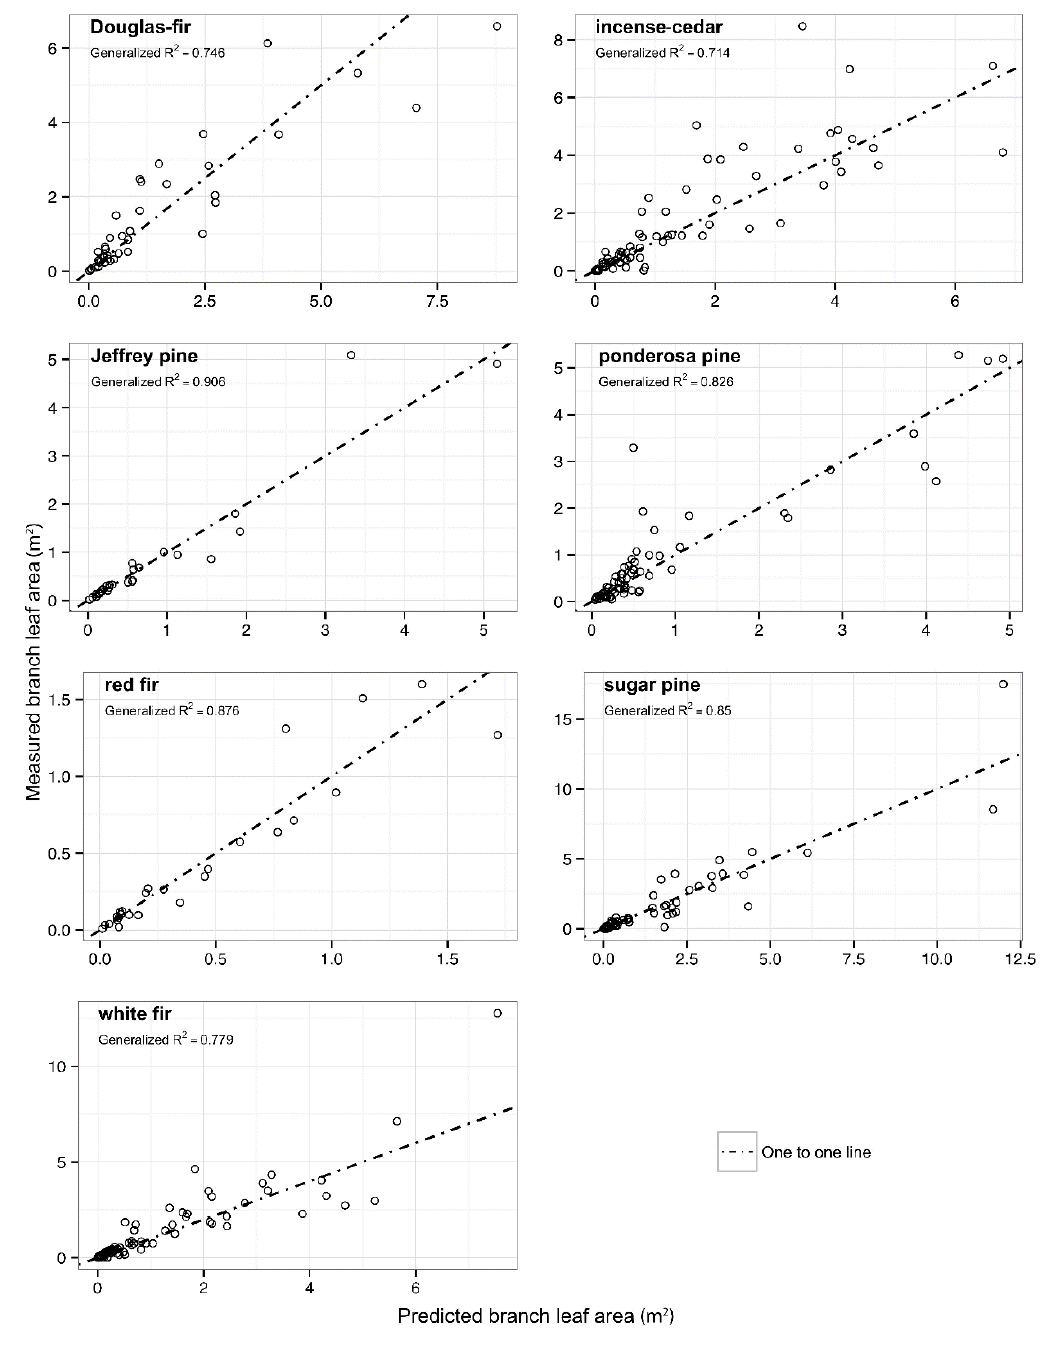
Figure 1. Measured branch leaf area as a function of predicted branch leaf area for seven conifer species. Generalized R 2 are shown as well as one-to-one lines to indicate scatter around theoretical line of perfect